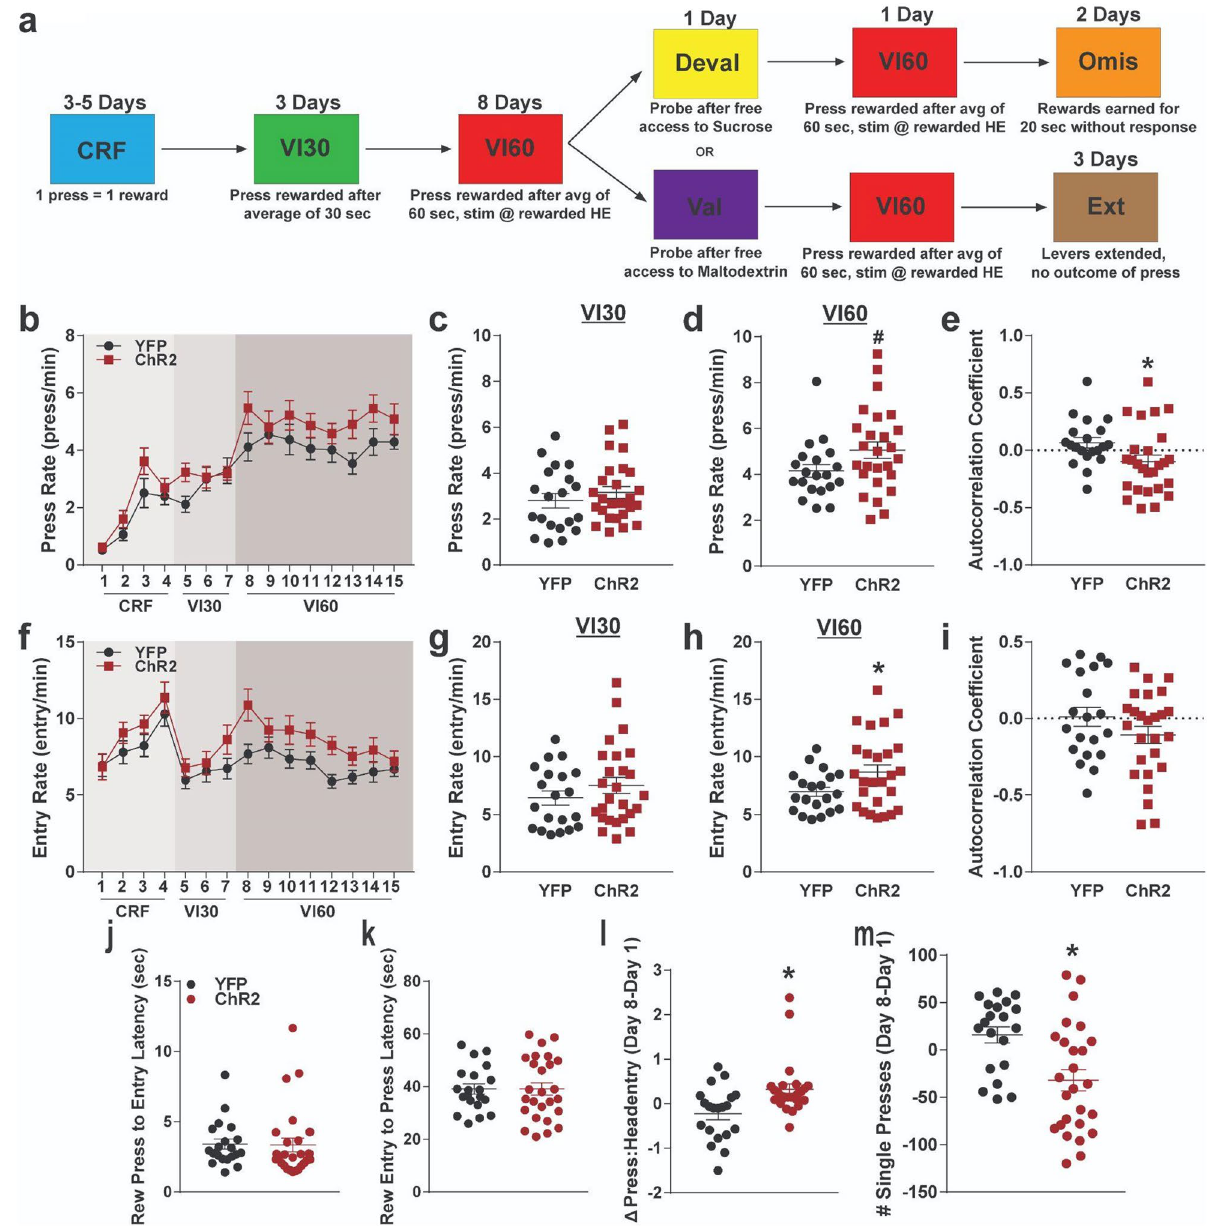
Figure 2. Optogenetic patch stimulation during variable interval training. ( a ) Timeline of behavioral schedule. Two groups of mice were trained on a continuous reinforcement schedule (CRF) before beginning variable interval 30 training (VI30). Following this, mice began a variable interval 60 schedule (VI60), and optogenetic stimulation of patches or patch projections occurred during reward retrieval. One group then underwent devaluation, where mice gained free access to the reinforcer earned during VI60 (10% sucrose) before being tested on a 5 min probe trial. After a day of VI60 retraining, these mice then experienced two days of omission (Omis), where they had to withhold responding to earn rewards. The second group of mice received identical training to the first, but instead of devaluation, these mice received access to an alternative reinforcer (10% maltodextrin) before being tested in a 5 min probe (valuation probe). This group then returned to VI60 training for one day before undergoing two days of extinction, where lever presses yielded no outcome. See Methods for details of each behavioral schedule. ( b ) Press rates for ChR2 and YFP control mice across training. ( c , d) Average response rates across VI30 ( c ) and VI60 ( d ). ( e ) Autocorrelation coefficients for press rates across VI60 training. ( f ) Head entry rates to the food magazine across training for ChR2 and YFP mice. ( g , h ) Average head entry rates across VI30 ( g ) and VI60 ( h ). ( i ) Autocorrelation coefficients for entry rates across VI60 training. ( j – k ) Latency between rewarded press to next head entry ( j ) and between reward retrieval and next lever press for YFP and ChR2 mice on the final day of VI60 ( k ). ( l ) Change in ratio of presses to head entries from day 1 to day 8 of VI60 training. ( m ) Change in number of single presses between head entries from day 1 to day 8 of VI60 training. * p < 0.05; # p < 0.1; error bars, SEM. a drawn in Illustrator CC 2019